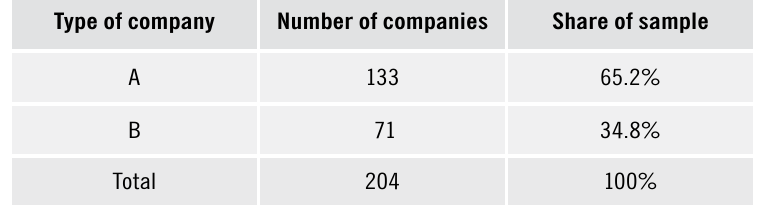
Table 2. Perceived psychic distance by investigated managers Type of